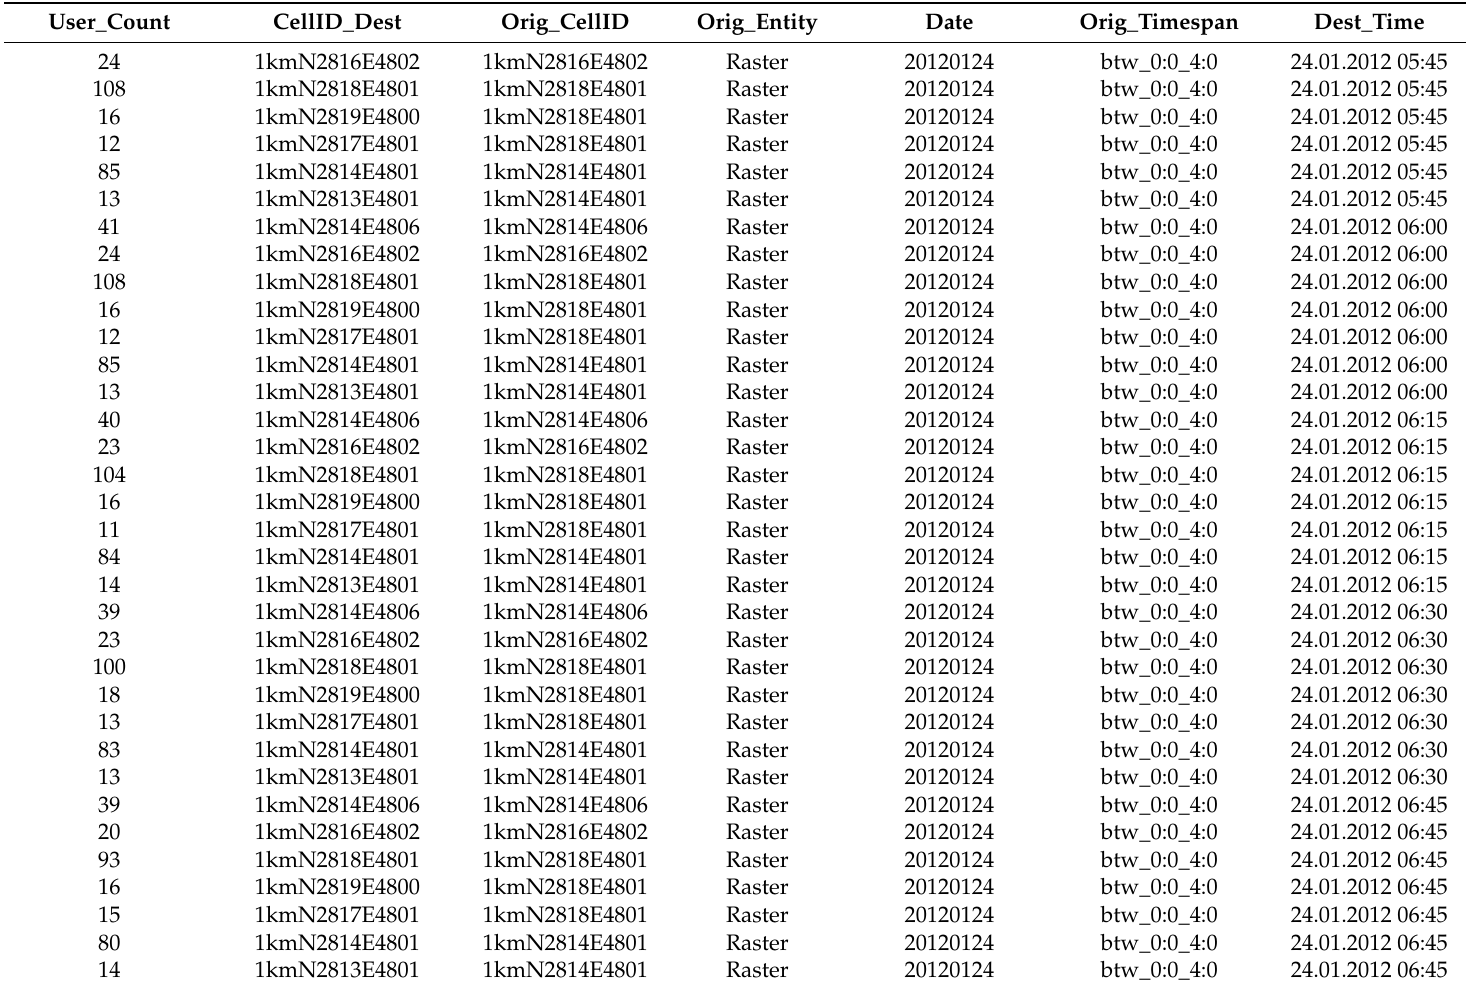
Table A3. Example of the O-D matrix extracted from the CDR